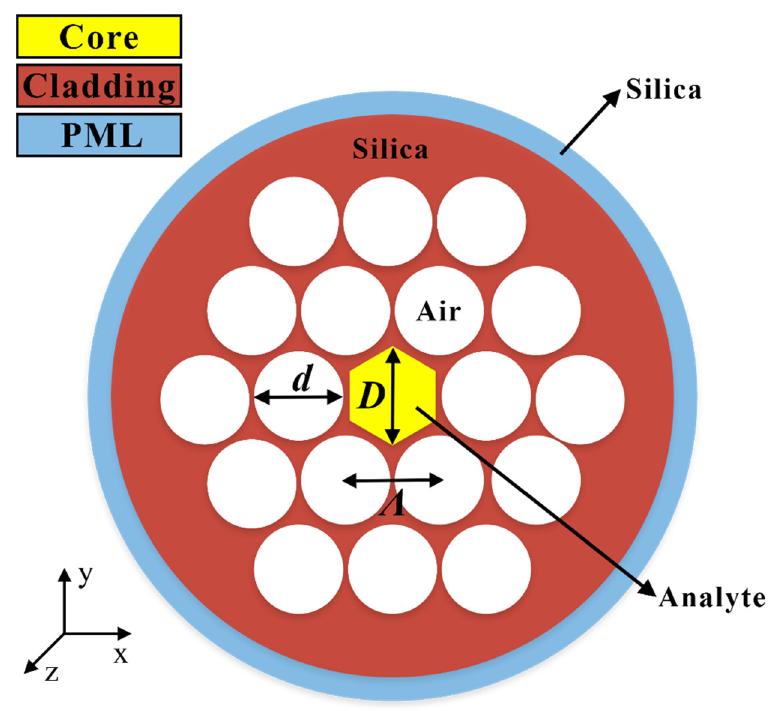
Figure 1. Schematic of the design proposed for the PCF.